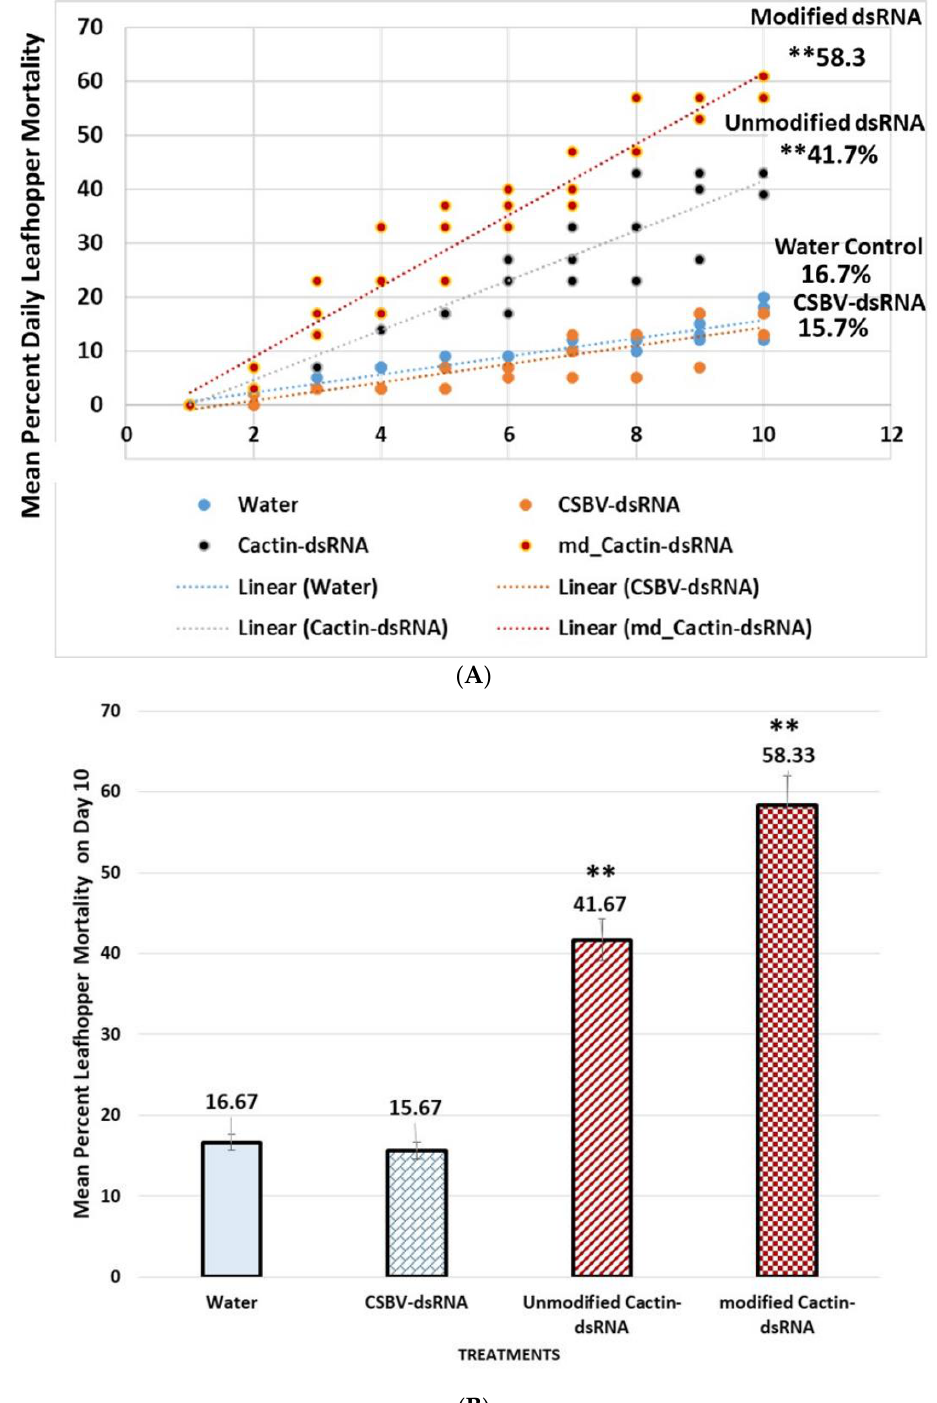
Figure 8. Percent Leafhopper Nymph Mortality. Analyses showed there was statistically significant differences between means of daily mortality over a 10-d feeding access period on treated okra cuttings ( A ), as determined by one-way ANOVA, with post-hoc Tukey (HSD) ( p < 0.05). There were significant differences at day 10, between the modified cactin -dsRNA (58.33%, ±SE 3.61) and the unmodified dsRNA treatment (41.67% (±SE 2.58) and both controls (** p < 0.01). There was no significance between the water control (16.67%, ±SE 0.95) and the CSBV-dsRNA control (15.67%, ±SE 1.03) ( p = 0.90) ( B ). Error bars represent ±SE of the means (n = 9) as determined from nine independent replicates, three technical replicates. Experiment repeated three times.